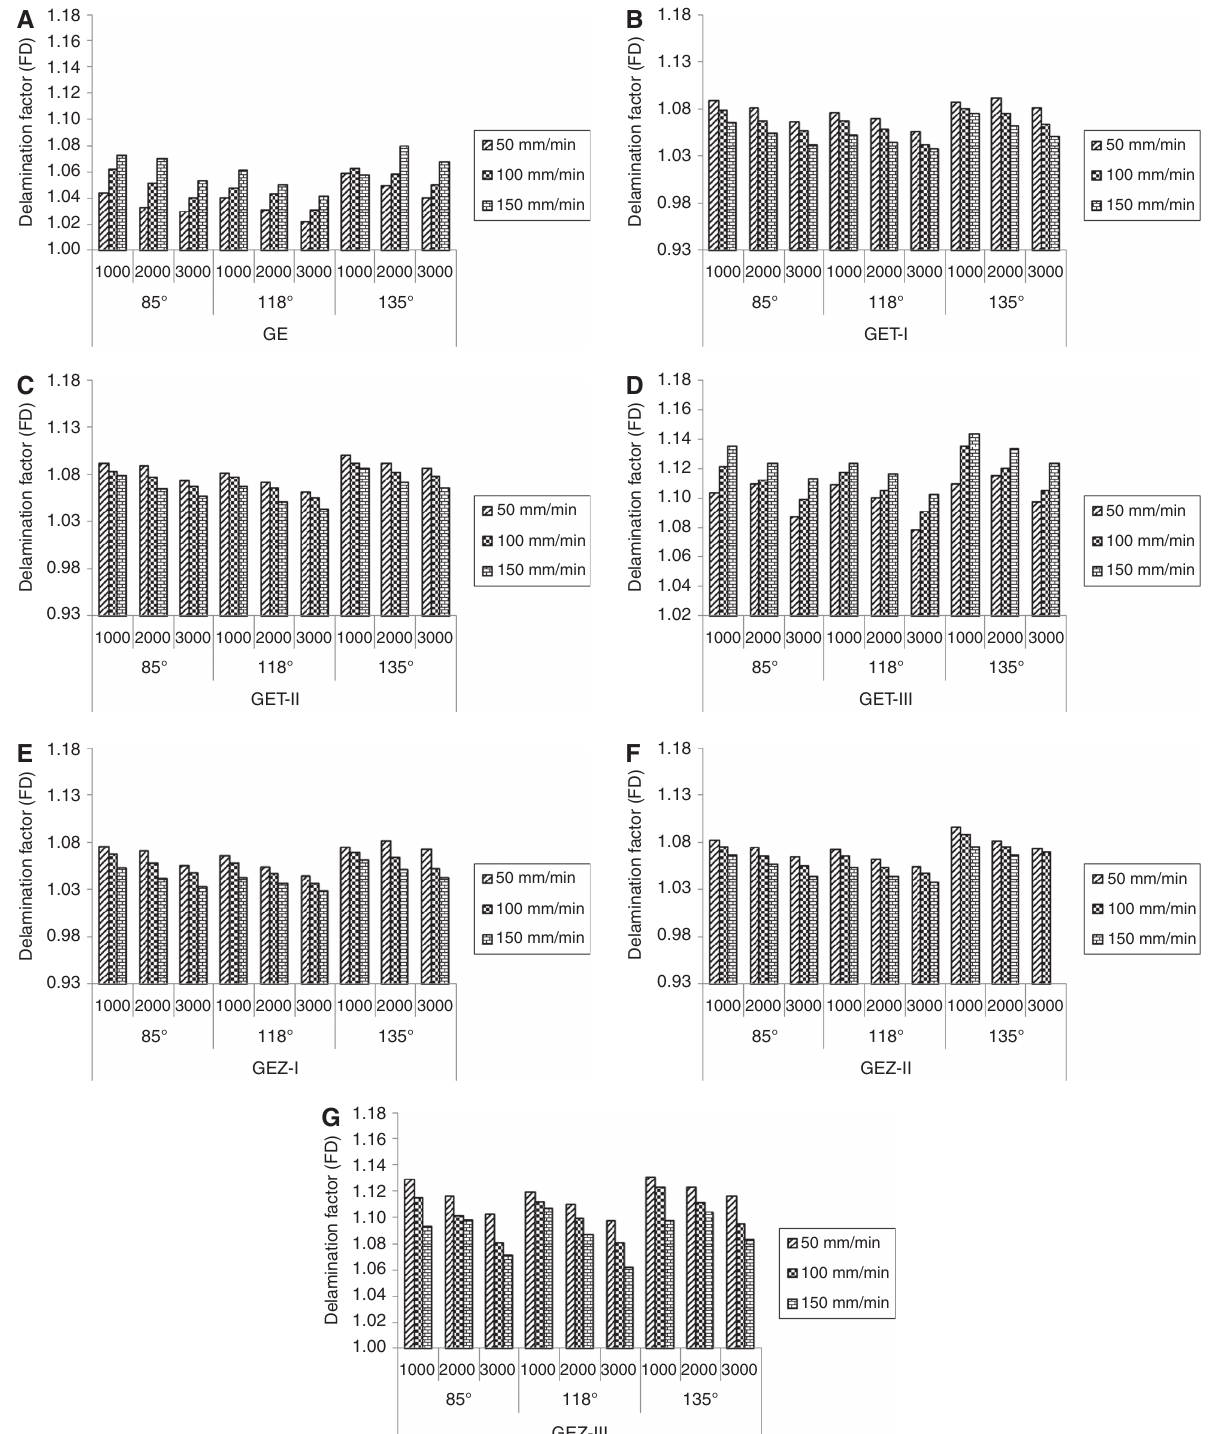
- and ZnS-filled GFRP composites. 2 however, at higher speed, the heat generated by friction between the major and minor cutting edges and the work material promotes the softening, which relates to less